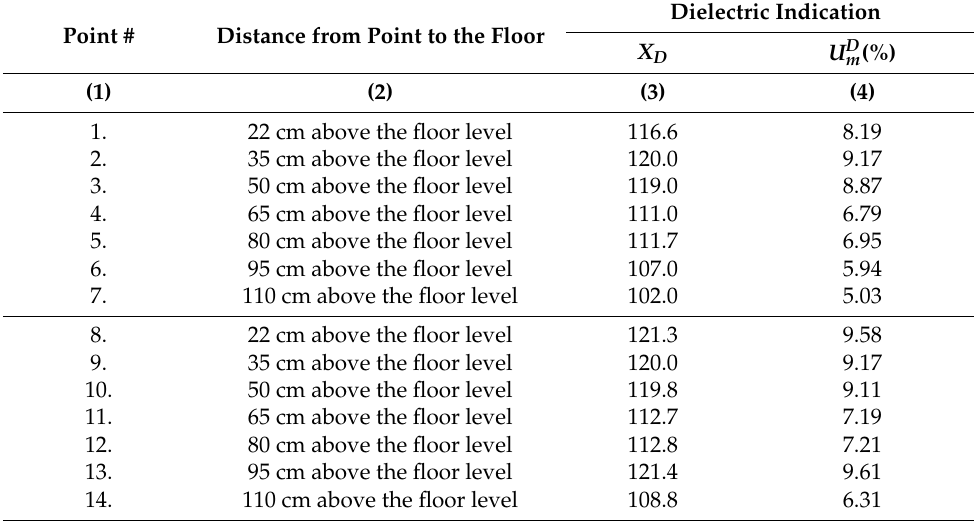
Table 1. Summary of validation measurements.